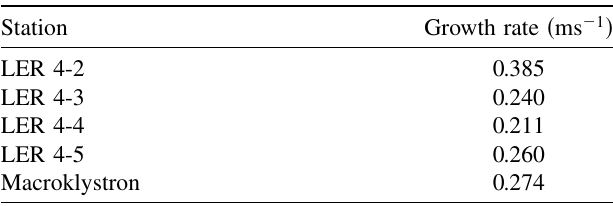
TABLE II. Growth rate vs station table. Station